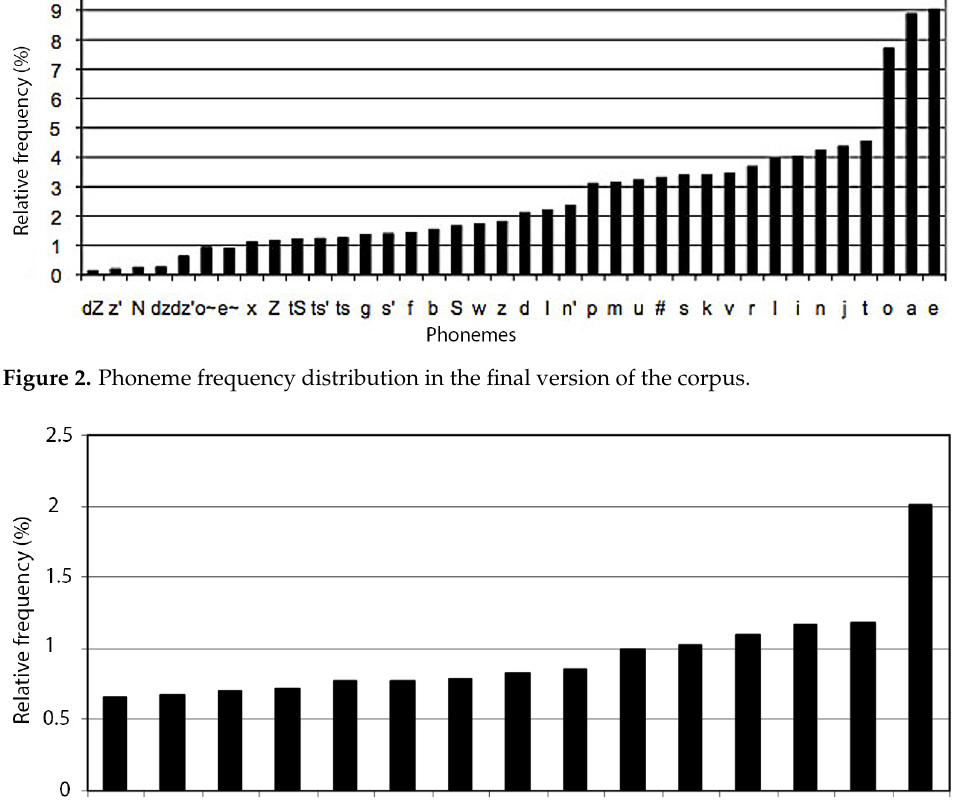
Figure 2. Phoneme frequency distribution in the final version of the corpus.